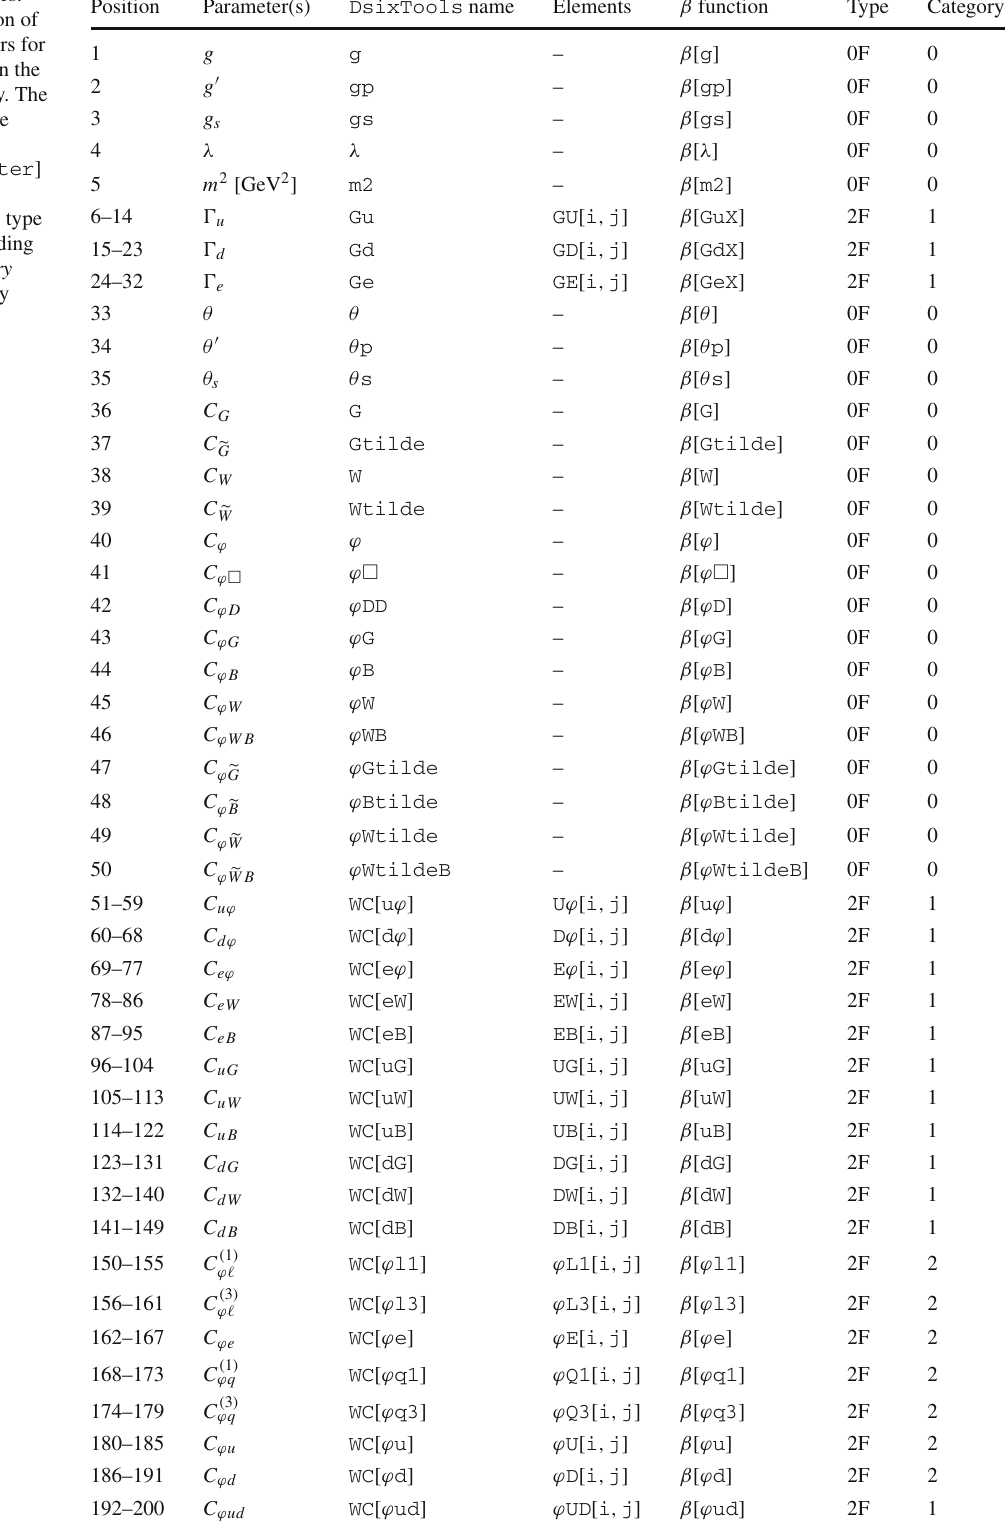
Table 6 SMEFT parameters. Position denotes the position of the parameter (or parameters for 2- and 4-fermion objects) in the Parameters global array. The column β function gives the name of the β function (obtained with β [ parameter ] after using the GetBeta routine). Type indicates the type of parameter (with nF standing for n-fermion) and Category denotes the index symmetry category of the coefficient, being relevant for 2- and 4-fermion